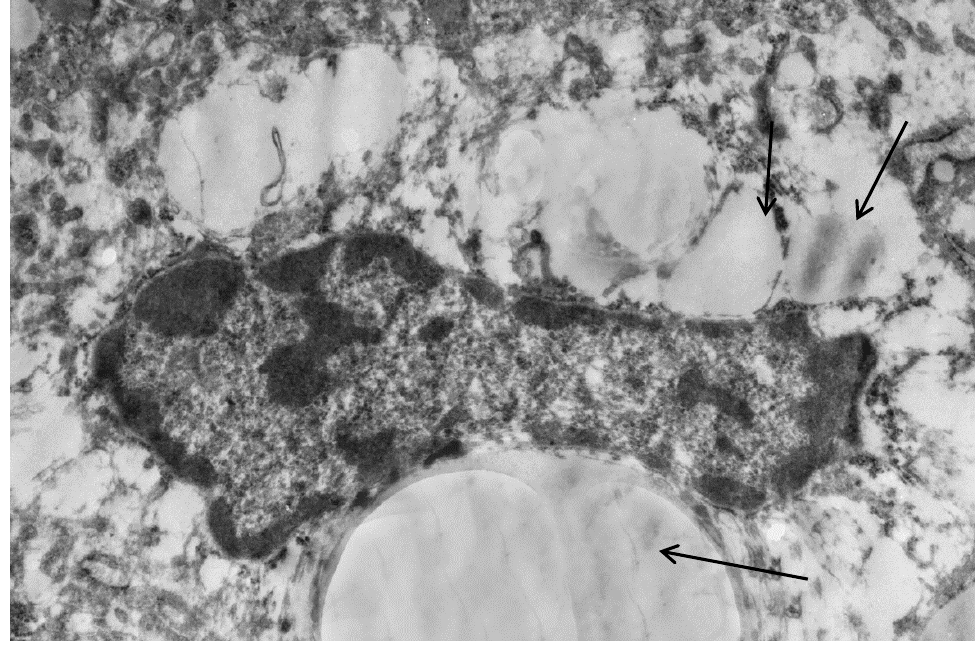
Figure 4. Liver macrophage in mice with acute lipemia, 24 h after P-407 administration. Lipids in cytoplasm (arrows). Magnification 6000×.